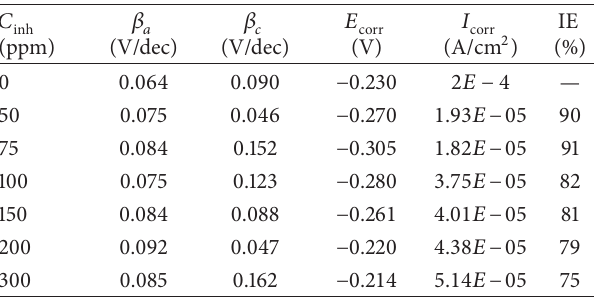
Figure 3: Effect of Opuntia ficus-indica concentration on the polar- ization curves for carbon steel in 1M HCl at 25 ∘ C. Table 1: Electrochemical parameters obtained fromthepolarization curves at 25 ∘ C.